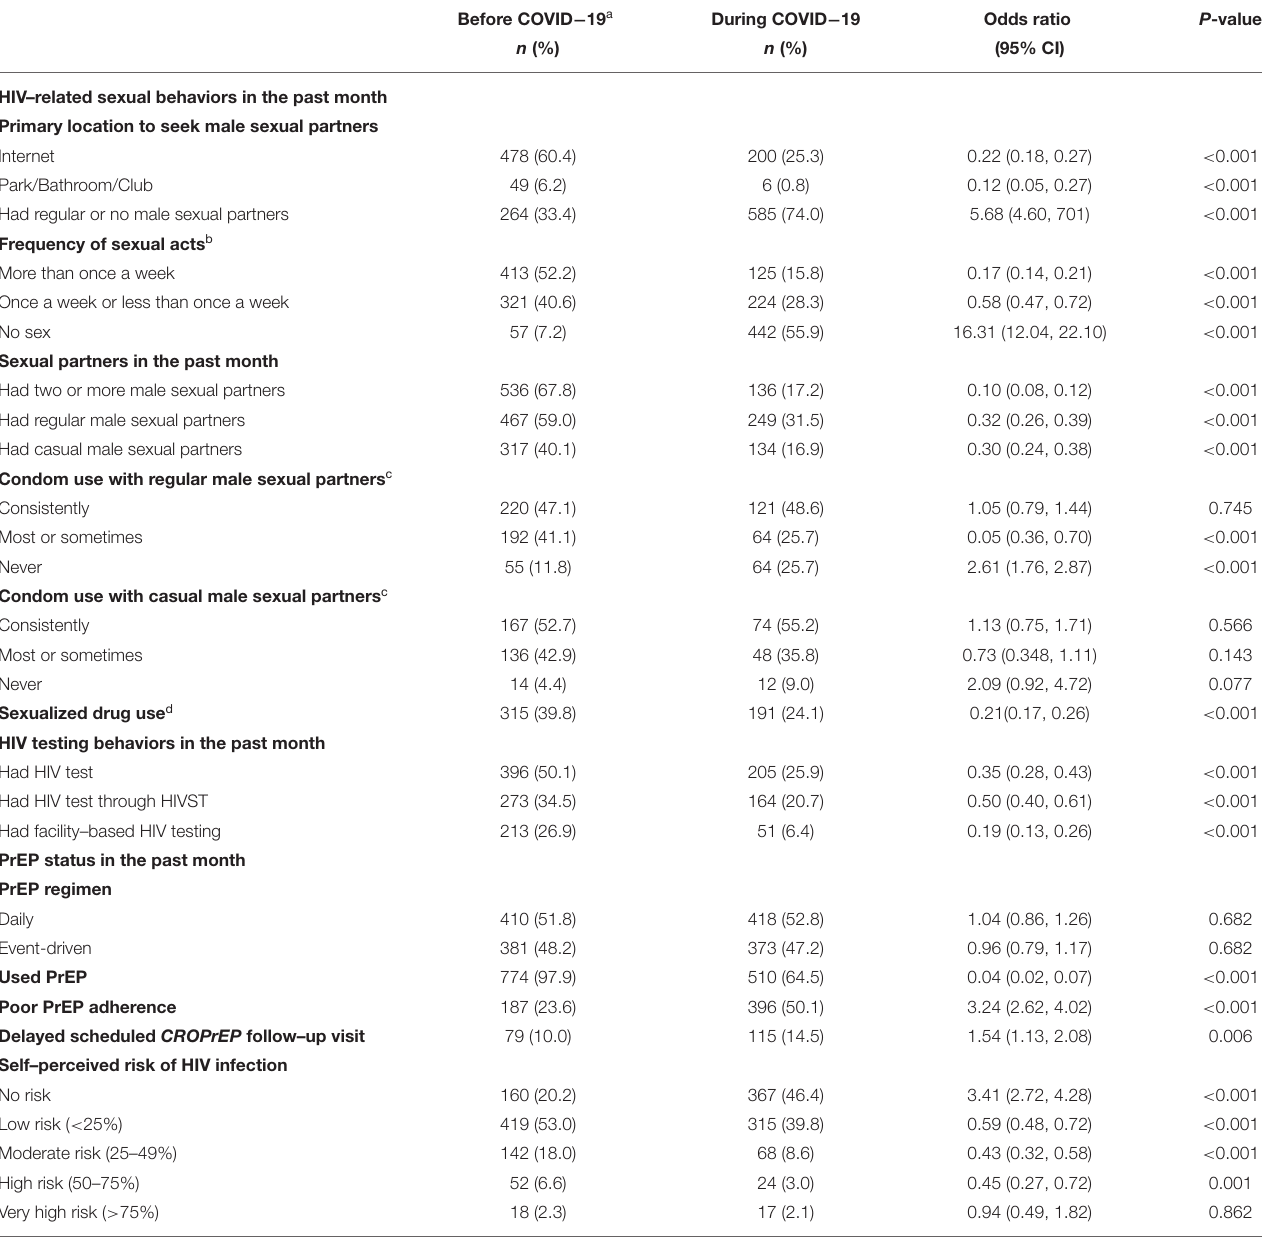
TABLE 2 | Changes in sexual behaviors, HIV testing, and PrEP adherence among during compared to before the COVID-19 ( N = 791). Before COVID − 19 a During COVID − 19 Odds ratio P